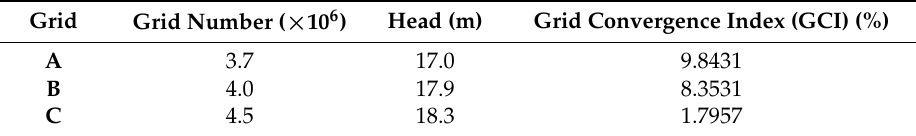
Table 2. Three different grid numbers for Grid convergence index